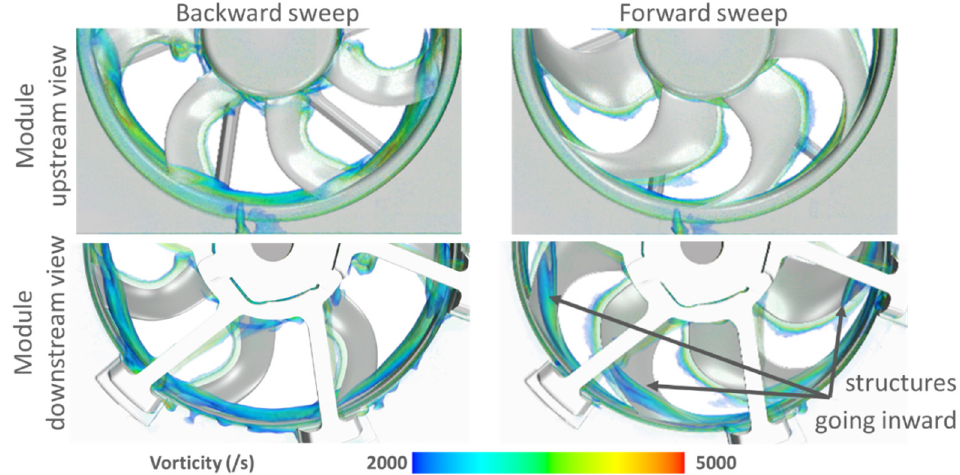
views): ( a ) backward curve, and ( b ) forward Figure 15. Vorticities in module configuration within the given range (upstream and downstream views): (a) backward curve, and (b) forward curve.